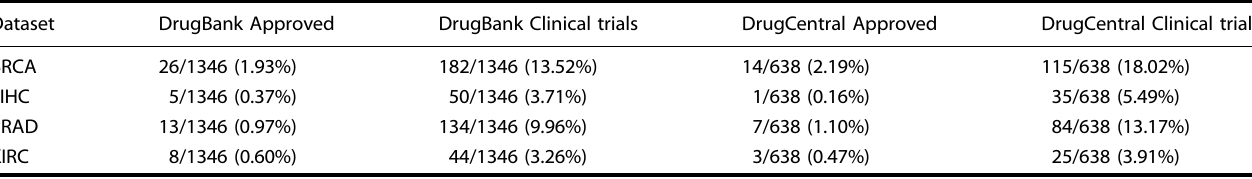
Table 3. Number of FDA-approved and clinically tested drugs present in both drug-target datasets across the four investigated cancers.